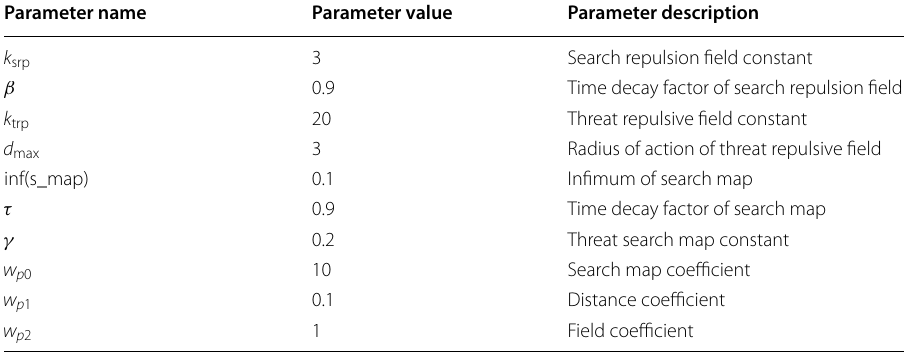
Table 3 Description and value of the HL-ACO algorithm parameters